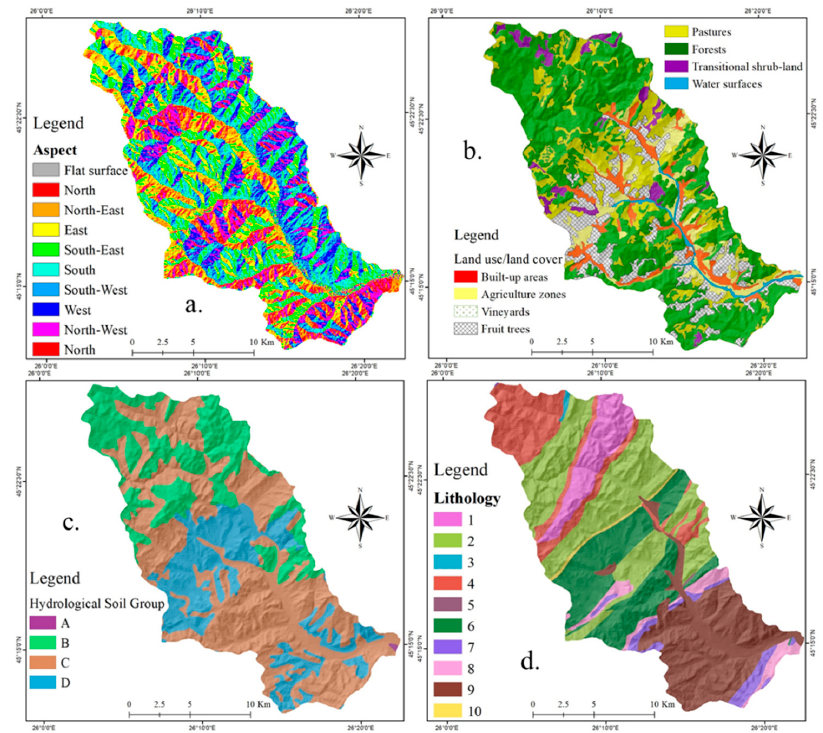
Figure 3. Flash-flood predictors: ( a ) Aspect; ( b ) Land use; ( c ) Hydrological soil groups; ( d ) Lithol- ogy.